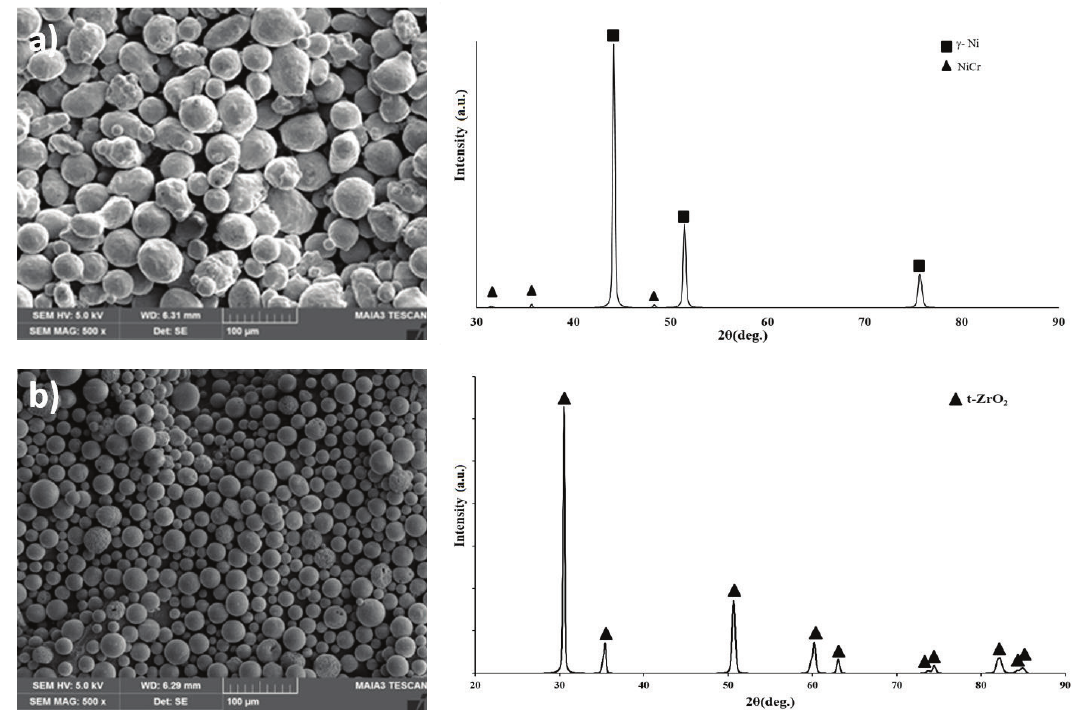
Figure 1: a) NiCr powders and XRD analysis, b) YSZ powders and XRD analysis. Table 1: Spraying parameters of NiCr and